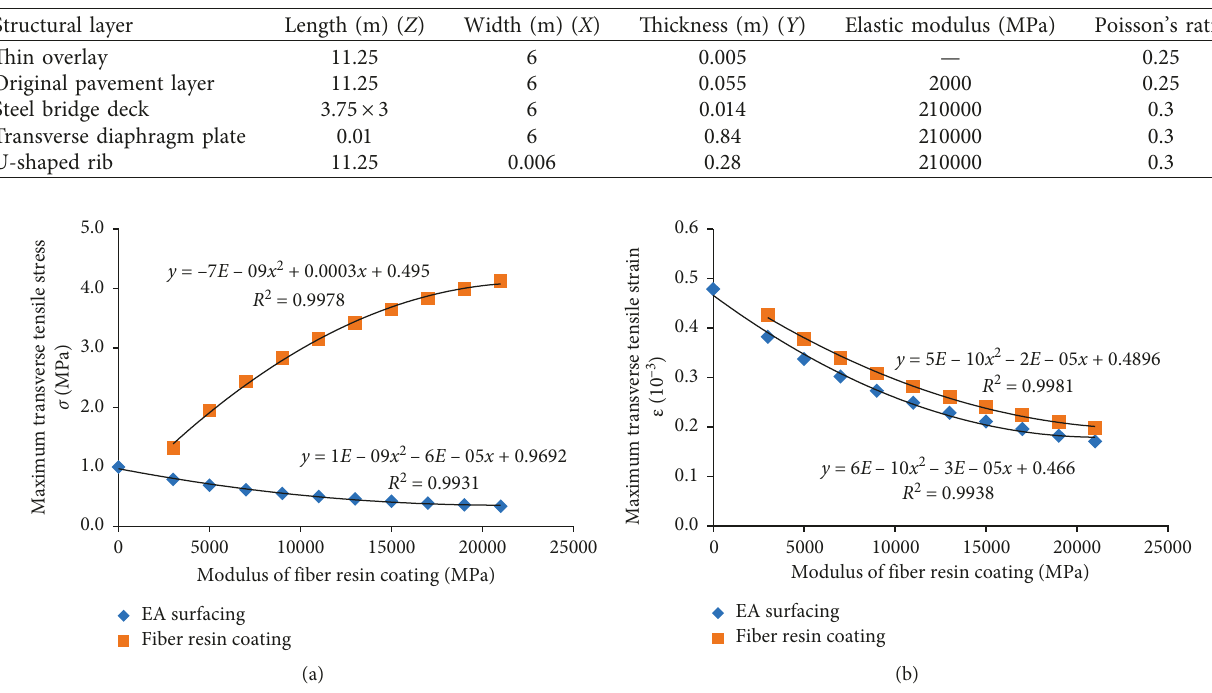
Table 4: Model parameters in finite element simulation.